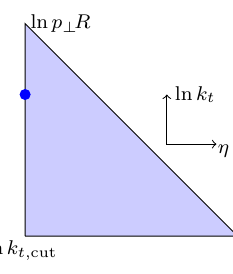
Figure 3 . Lund representation of the only new NDL contribution for high-energy jets: a large- angle